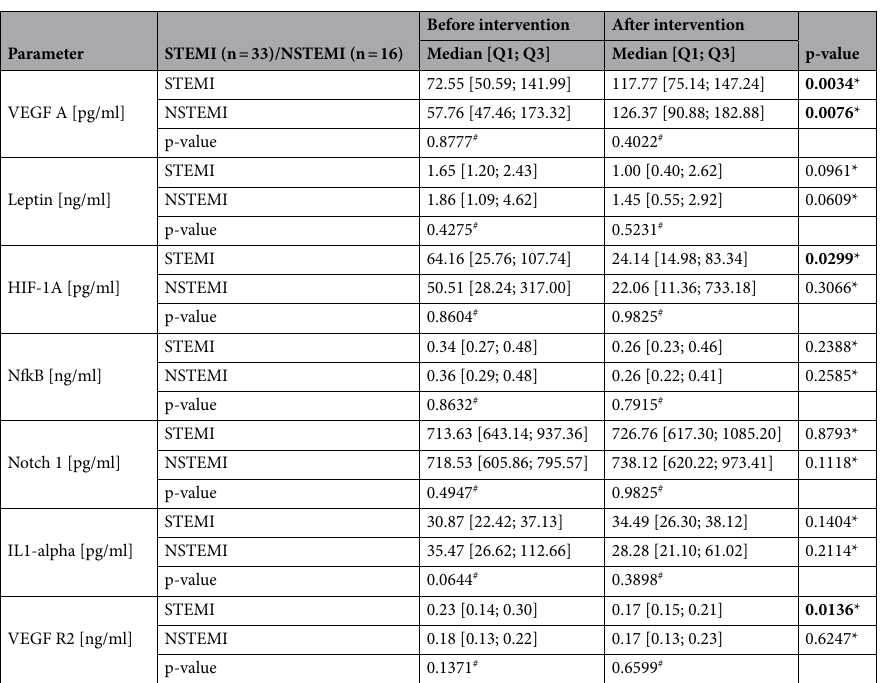
Table 11. Comparison of serum concentration of biochemical parameters between STEMI and NSTEMI patients in subjects from group S. Data are presented as median [Q1; Q3]. HIF-1A: hypoxia-inducible factor 1 alpha; IL1-alpha: interleukin 1 alpha; NfkB: nuclear factor kappa-light-chain-enhancer of activated B cells; Notch 1: Notch protein 1; NSTEMI: non-ST-segment elevation myocardial infarction; Q1: first quartile; Q3: third quartile; STEMI: ST-segment elevation myocardial infarction; VEGF A: vascular endothelial growth factor A; VEGF R2: vascular endothelial growth factor receptor 2. *Wilcoxon test; # Mann–Whitney test. Significant values are given in